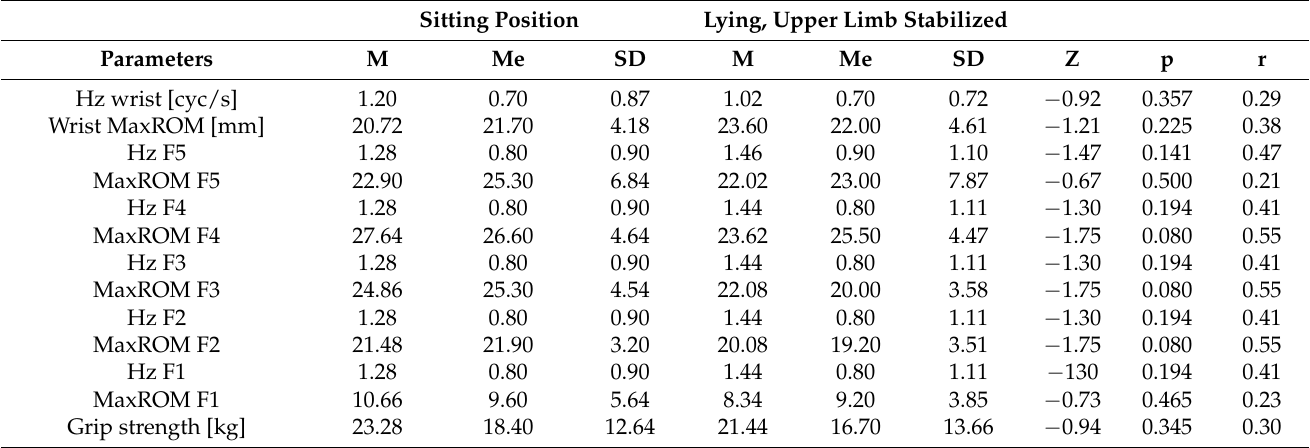
Table 7. Comparison of movement and strength parameters in sitting and lying positions with upper limb against the body in patients after cerebellar ischemic stroke. Sitting Position Lying, Upper Limb Stabilized